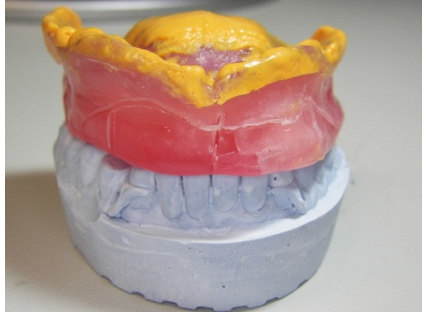
Figure 2. Baseplate-wax rim.